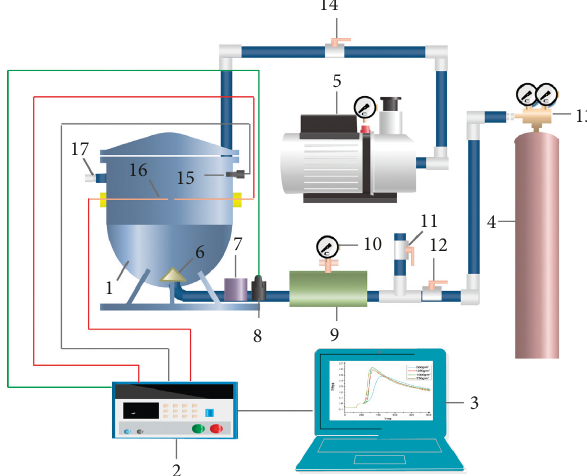
Figure 1: The 20L explosive spherical tank. (1) 20 L spherical